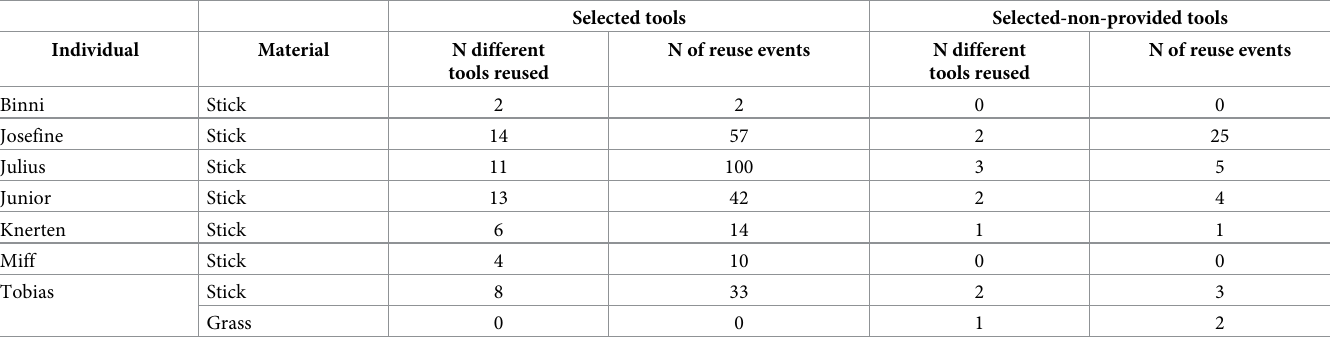
Table 6. Number of tools reused and number of reuse events per individual during Experiment 1. Selected tools Selected-non-provided